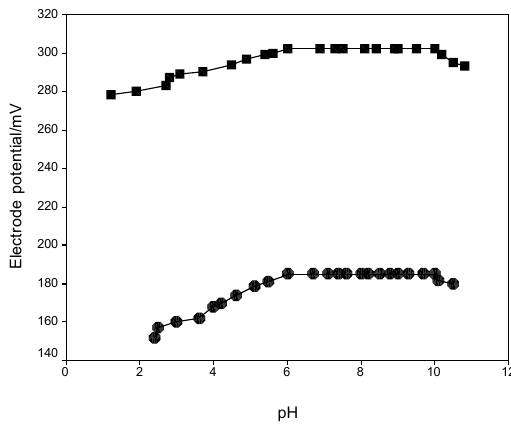
5.55.04.54.03.53.02.52.0 -log conc of phenytoin sodium (M) -log conc of phenytoin sodium (M) Figure 5. Calibration graphs obtained at 25±1ºC after soaking Figure 6. Regeneration of phenytoin-tungstosilicate-PVC membrane the phenytoin-tungstosilicate- coated wire electrode for electrode ( ● ) calibration graph of the exhausted electrode, (  ) 4 h, ( ● ) 24 h, ( ○ ) 7 days,( ■ ) 10 days, ( ▼ ) 20 days, ( ■ ) calibration graph of a regenerated electrode (+) 25 days, ( ∆ ) 30 day, (*) 37 days